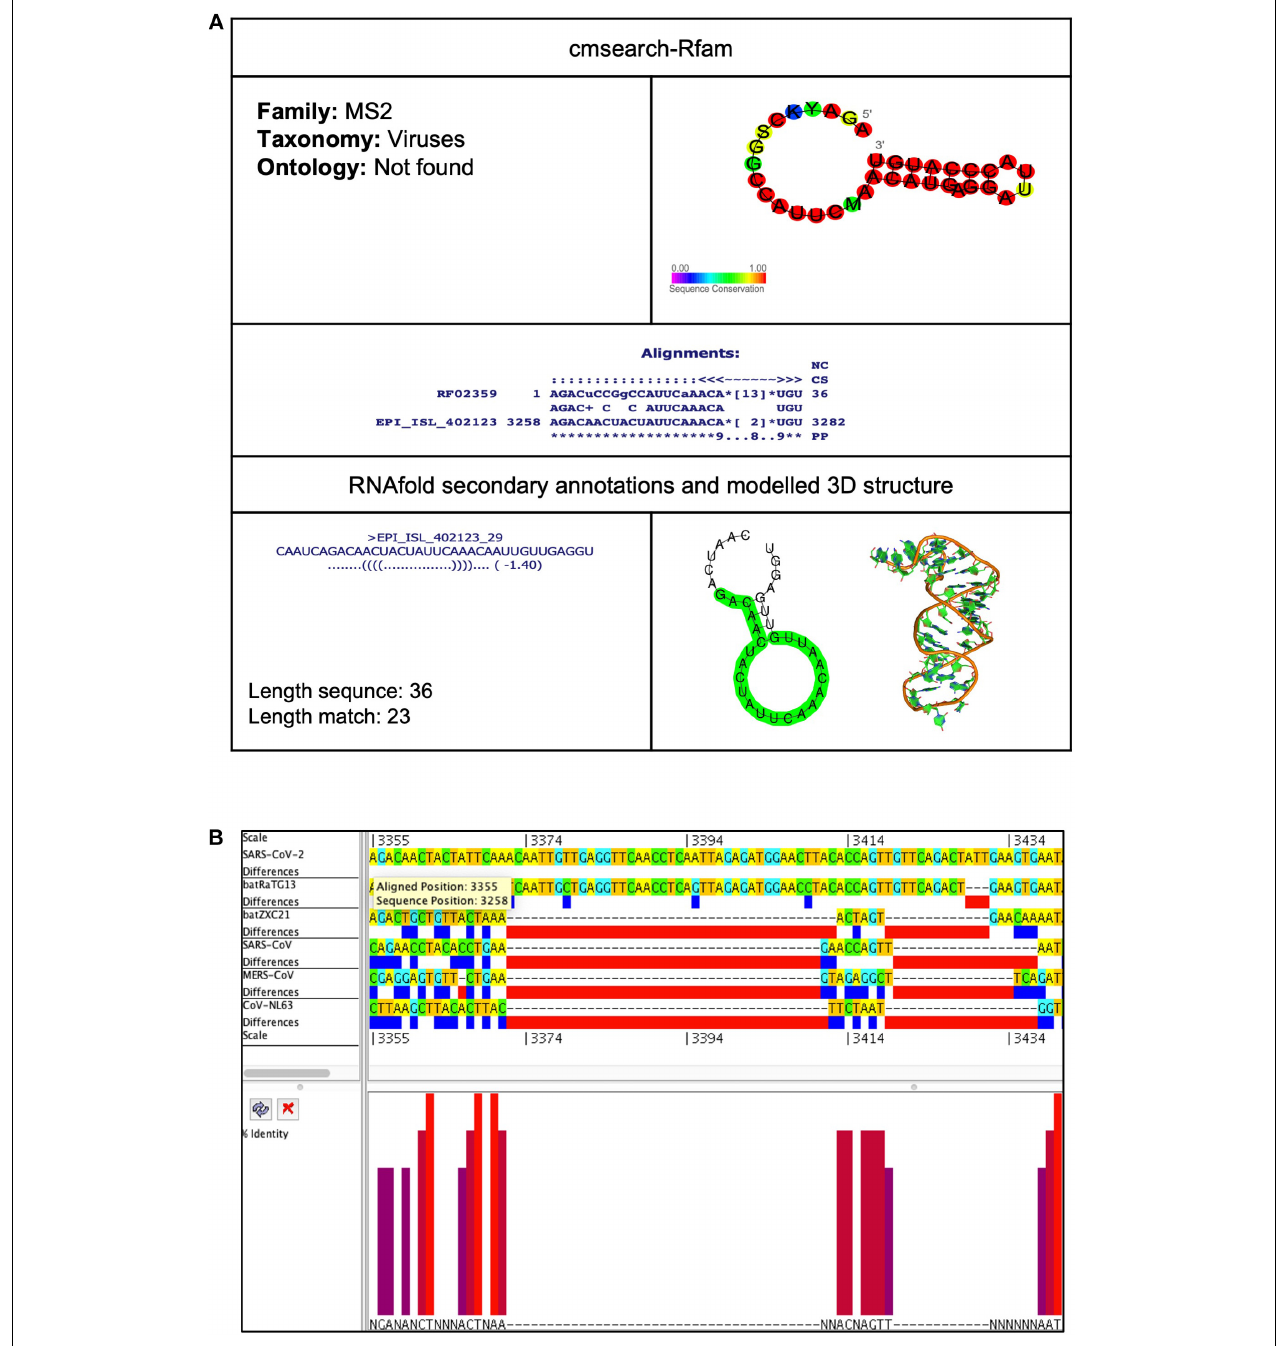
FIGURE 9 | MS2 cis -acting RNA element in the SARS-CoV-2 genome. (A) The sequence and RNA structure of MS2 is located in position 3,258–3,282 of the SARS-CoV-2 genome. In the 3-D structure, the phosphodiester backbone is shown in orange, and the nucleotides are shown in the sticks and filled rings with elemental coloring as C green, O red, and N blue. (B) Conservation of MS2 RNA sequence from various CoVs. The MS2 is located as aligned position 3,355–3,379. The navy blue box indicates mismatched nucleotides between the two sequences, and the red box indicates gaps between two sequences. Percentage identity in the histogram in which red indicates a perfect match and magenta indicates the low similarity of nucleotide.